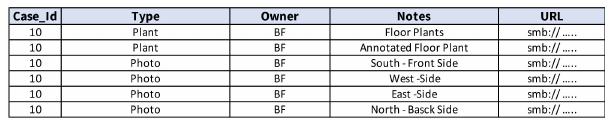
Figure 10. The File System Table for Case No.